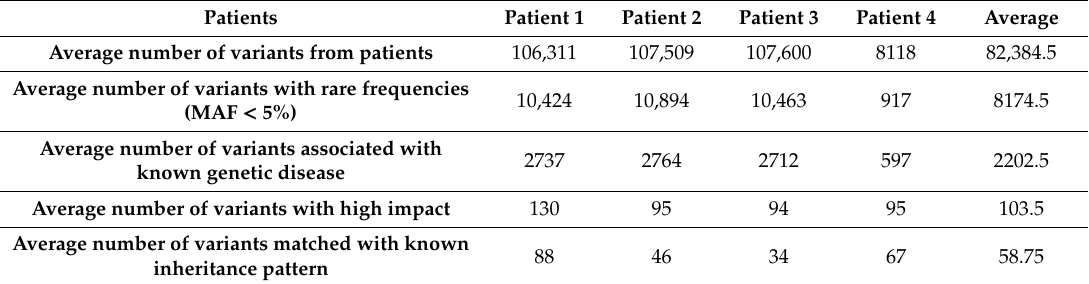
Table 2. Number of variants of each patient which were carried from whole exome during